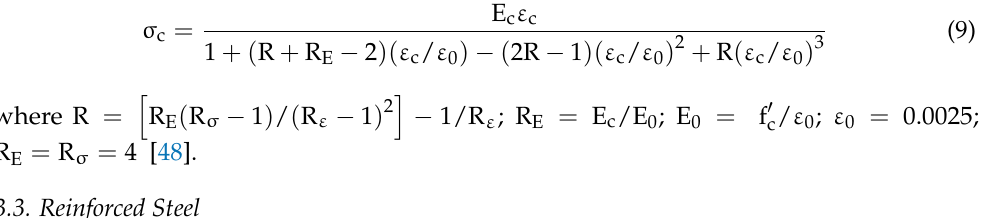
Figure 7. Bilinear traction–separation response. The initiation and evolution of damage in the available traction–separation model were initially assumed to be a linear–elastic behavior [50,51], which can be written in a matrix form as follows: